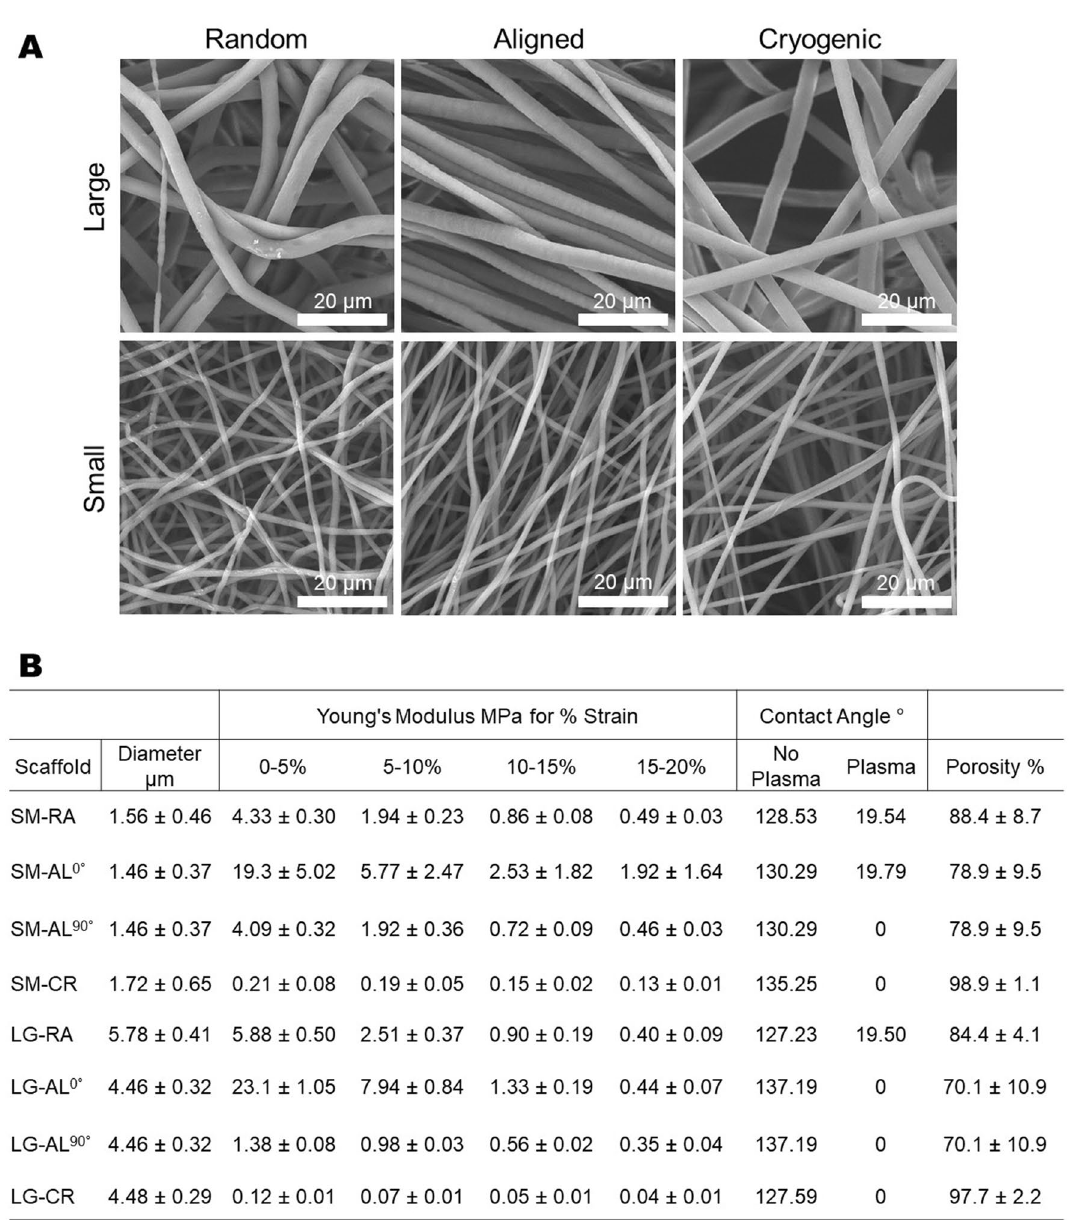
Figure 1. ( A ) SEM images of scaffold fibres for each group. ( B ) Fibre diameter measurements from Diameter J plugin, Tensile mechanical stiffness for each scaffold group (N = 5 presented as mean ± SD), Contact angle measurements for each scaffold group (0 indicates droplet completely absorbed) before and after plasma treatment and porosity